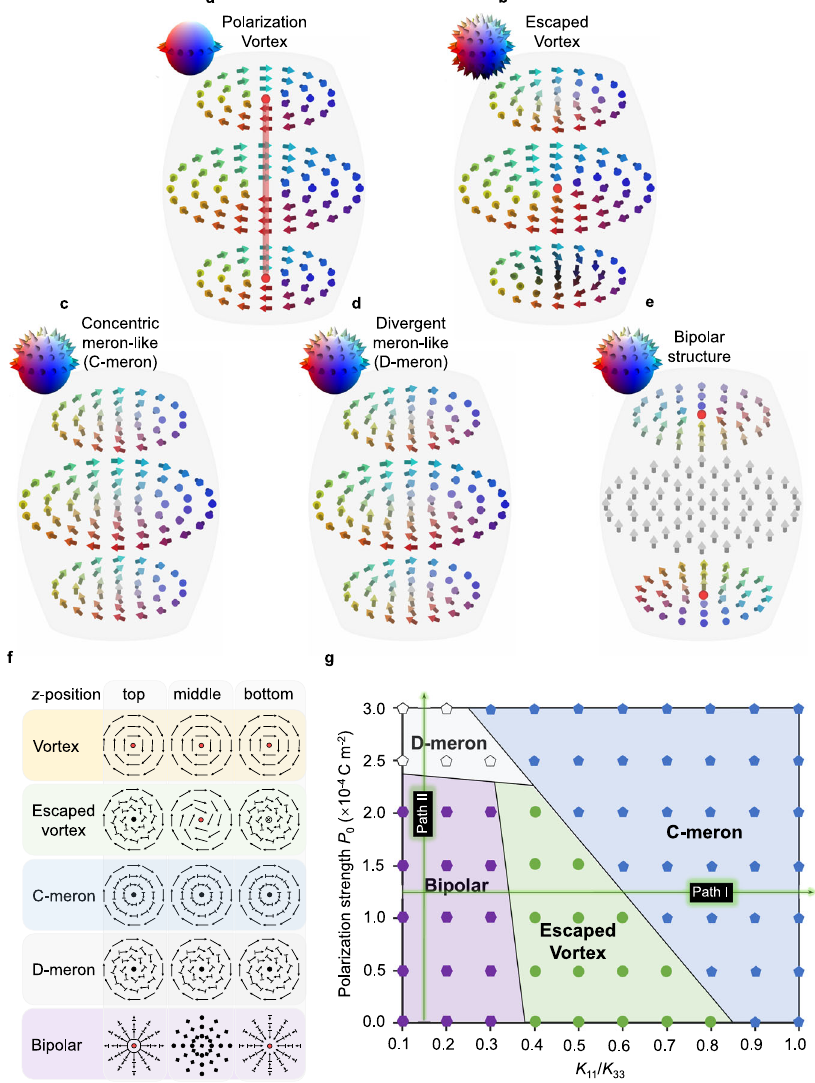
Fig. 6 | Topological structures of the N F phase in cylindrically con fi ned space. a – e Director fi elds and the corresponding order parameter space of simple polarization vortex ( a ), escaped vortex ( b ), concentric meron-like structure ( c ), divergent meron-like structure ( d ), and bipolar structure ( e ). f The polarization fi elds projected on the xy-plane in different depth positions of the droplets are described nail vectors. Red points mean point or line defect. g State diagram